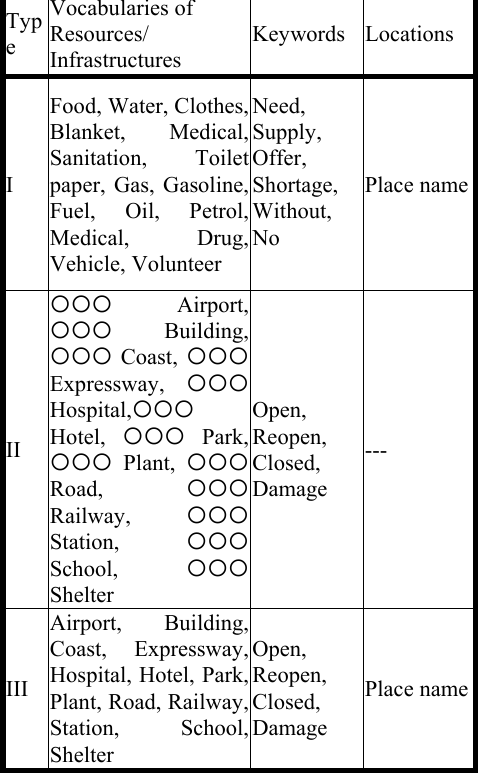
Table 1. The three types of triple-like structures used to extract disaster relief